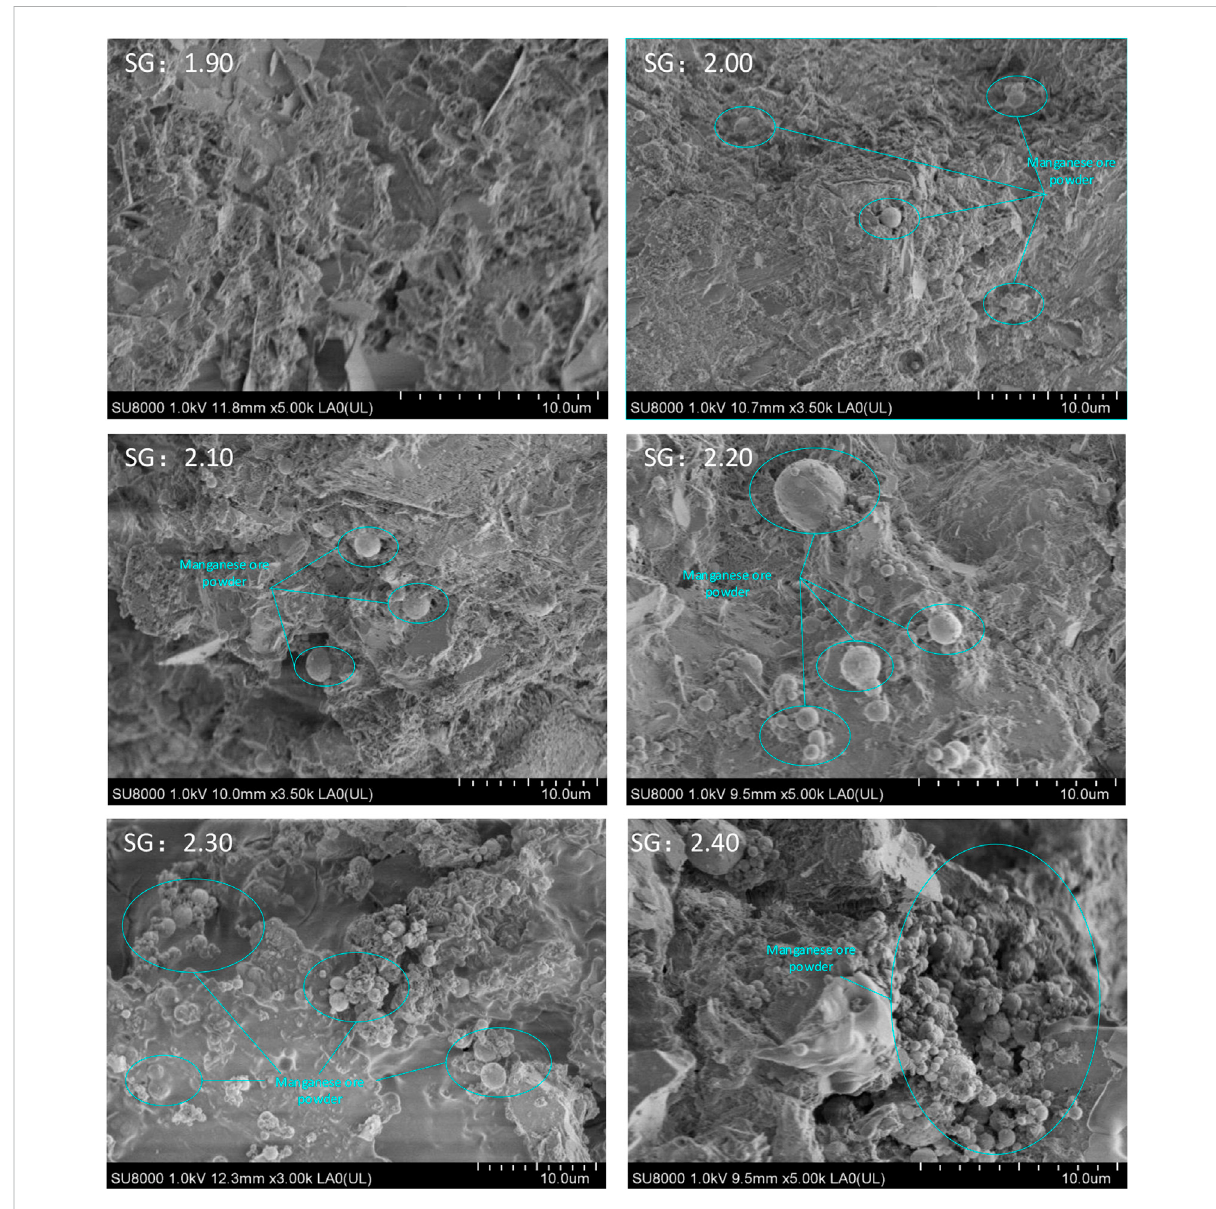
FIGURE 7 Microstructure of multicomponent composite anti-corrosion cement slurry system under different densities.